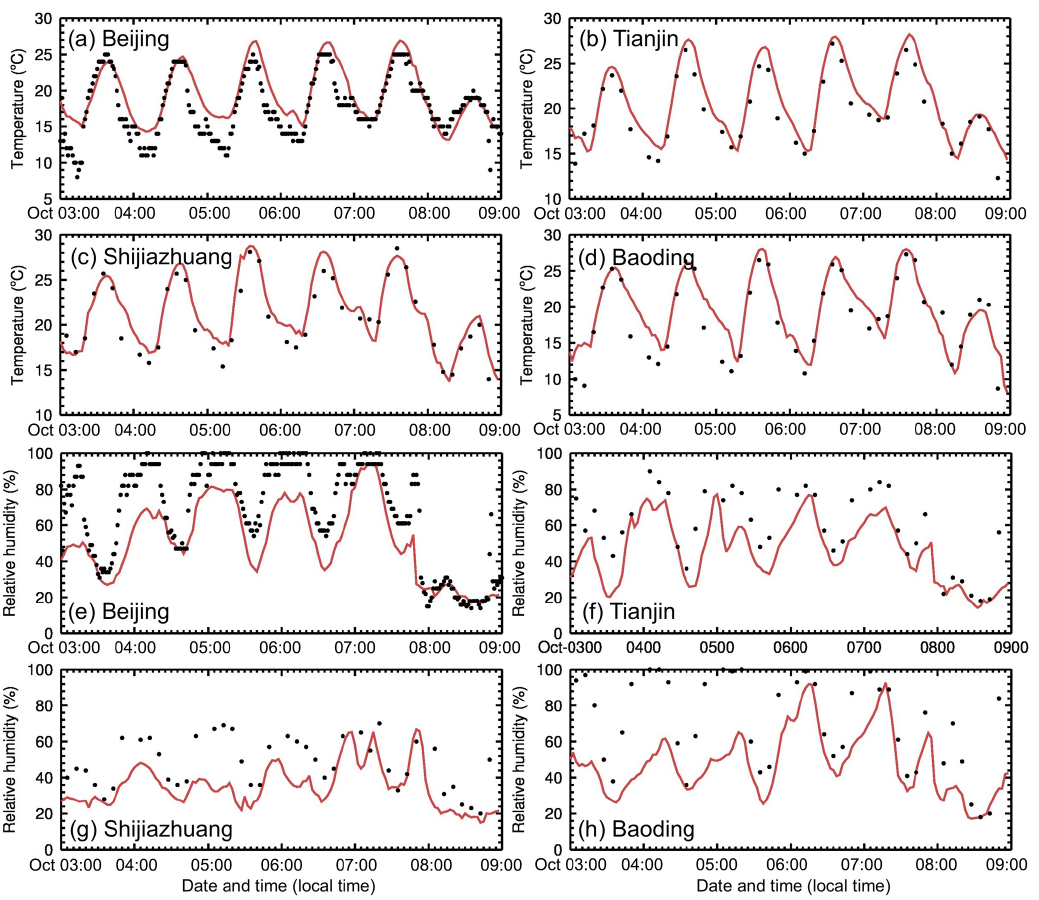
Figure 4. Simulated (red curves) and observed (black dots) temporal profiles of surface (a–d) temperature and (e–h) relative humidity in (a, e) Beijing, (b, f) Tianjin, (c, g) Shijiazhuang, and (d, h) Baoding from 3 to 8 October